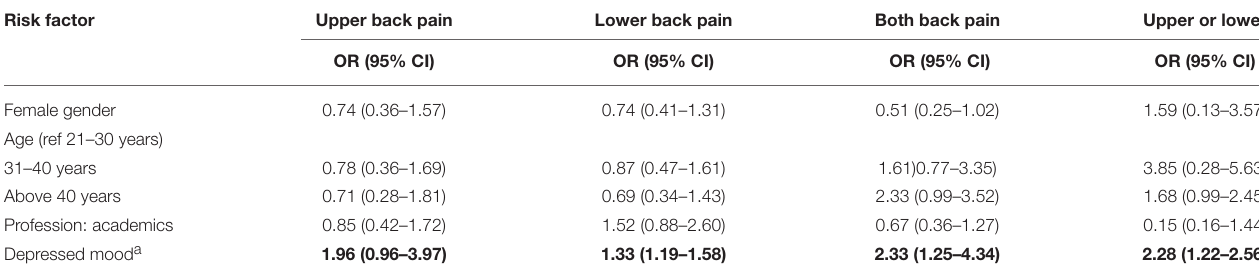
TABLE 3 | Relationship between depressed mood and back pain after adjusting for age and gender.